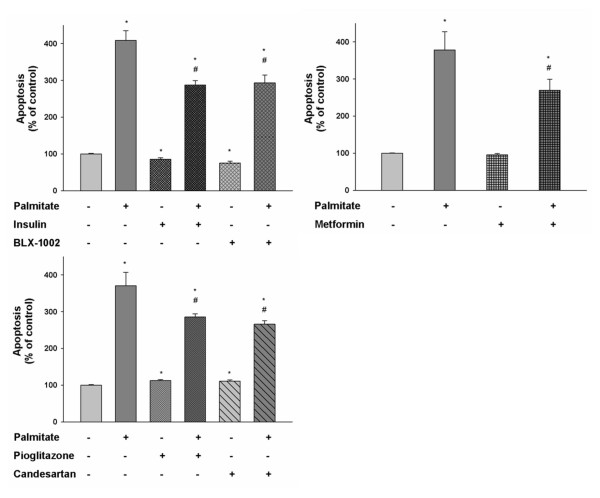
Insulin, metformin, BLX-1002, pioglitazone and candesartan protect HCAECs against palmitate-induced DNA fragmentation. To further corroborate the protective effects of the agents against lipotoxicity-induced apoptosis, DNA fragmentation was evaluated using the Cell Death Detection kit ELISAplus. Cells were exposed for 24 h to 0.125 mM palmitate or vehicle at 5 mM glucose with or without insulin lispro (1 nM), BLX-1002 (1 μM), metformin (500 μM), pioglitazone (2.5 μM), candesartan (100 nM). * denotes P < 0.05 for a chance difference vs controls by ANOVA, # denotes P < 0.05 for a chance difference vs palmitate by ANOVA.